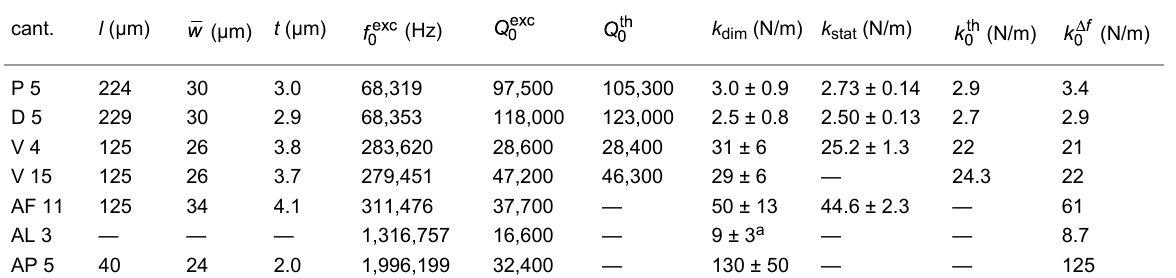
Table 1: Synopsis of cantilever properties. Cantilever dimensions are the length l (±2.5 µm), mean width (±1.5 µm) and thickness t (±0.2 µm) as provided by the manufacturer. The stiffness k dim is calculated from the cantilever dimensions, while k stat is determined by a precision measurement of the static stiffness [16]. Eigenfrequency (standard deviation below 1 ppm) and quality factor (standard deviation below 1%) are obtained from a fit of the simple harmonic oscillator transfer function to the measured resonance curve of the excited cantilever [12]. and are the prop- erties yielded when fitting Equation 3 to the displacement noise spectral density of a thermally excited cantilever. The value is extracted from the frequency shift noise from Equation 6 by using and as known